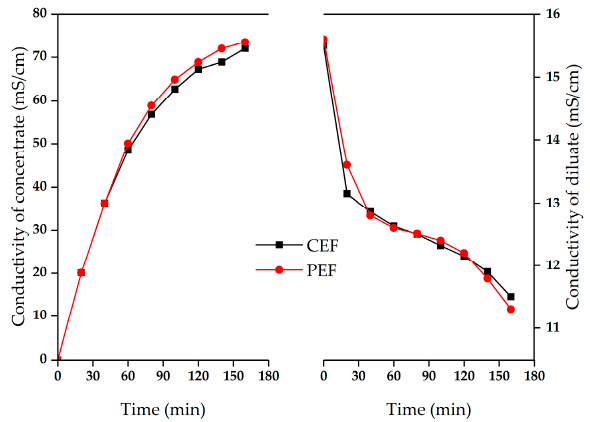
Figure 4. Membrane stack resistance and current density in the demineralization of sodium gluconate mother liquor. The conventional direct-current power and the pulse direct-current power operated at constant voltage of 9 V.